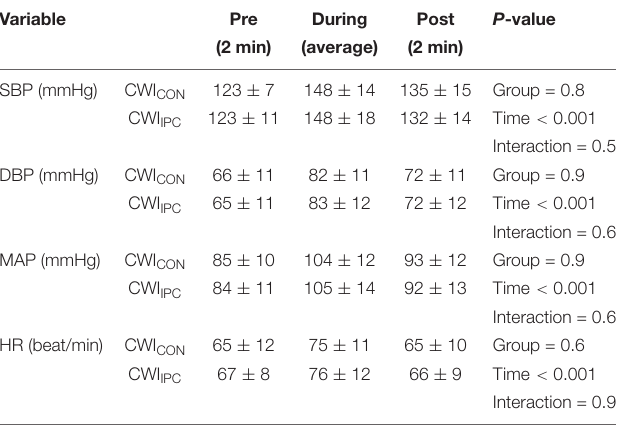
TABLE 1 | Hemodynamic parameters measured throughout a cold-water immersion test without (CWI CON ) and with (CWI IPC ) preceding IPC administration. Variable Pre